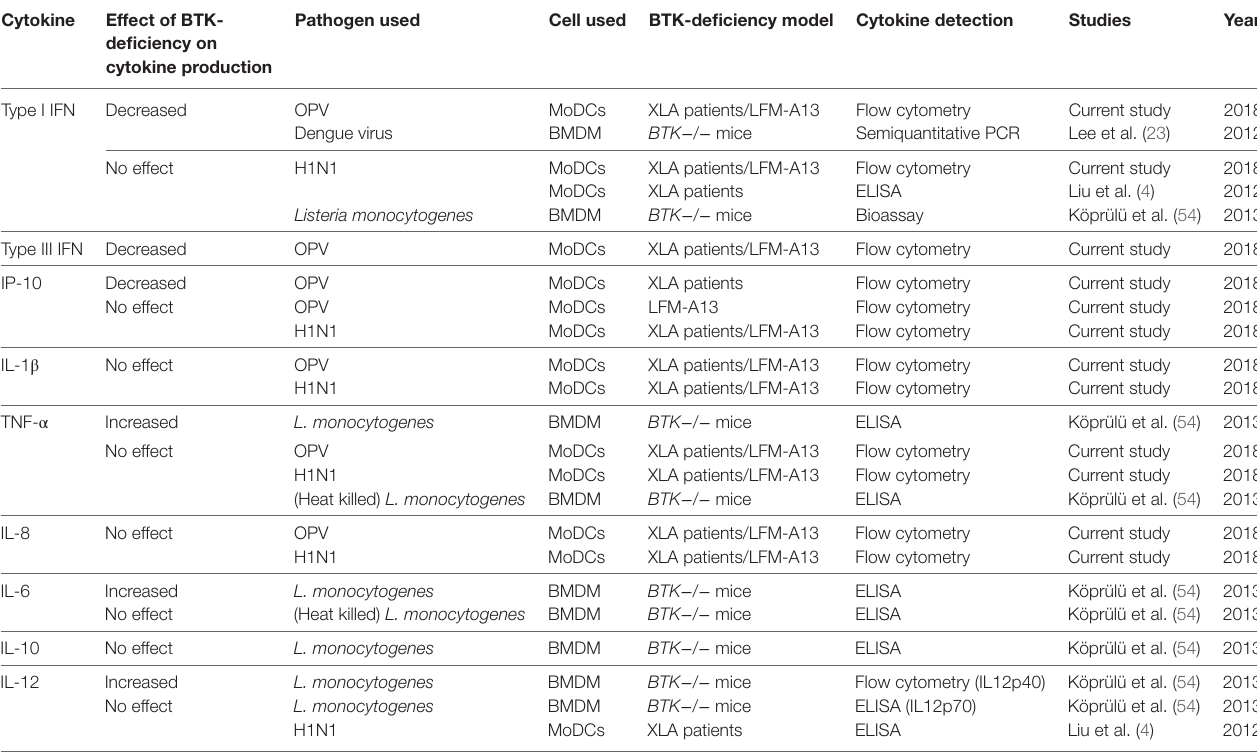
TaBle 3 | Studies of the effect of BTK deficiency on cytokine productions in response to pathogen stimulation. cytokine effect of BTK- deficiency on cytokine